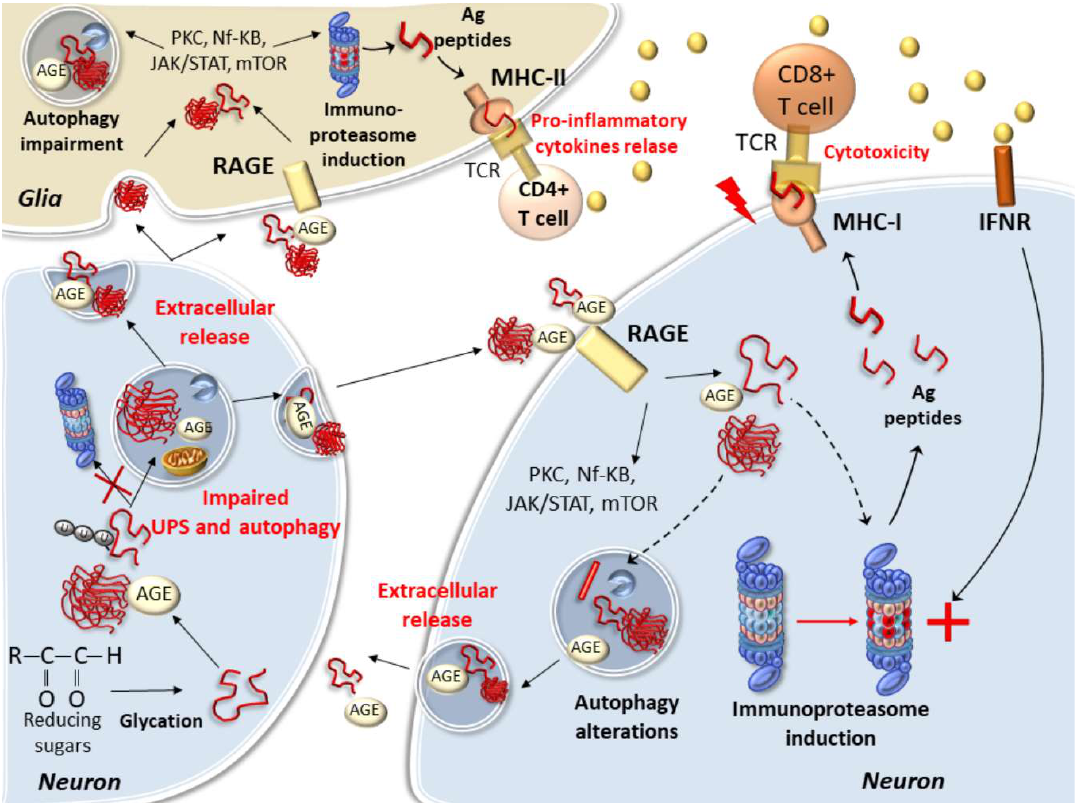
Figure 2. Autophagy and UPS alterations bridging altered proteostasis with neuroinflammation, the paradigm of protein glycation. Within neurons, glycation leads to the formation of advanced glycation end products (AGEs) which structurally modify proteins while promoting the formation of oligomer species. These in turn may impair the UPS while engulfing the autophagy pathway. Thus, indigested AGE-modified proteins may be released extracellularly upon merging of autophagy compartments with the plasma membrane. In neighboring cells, including neurons and glia, the presence of RAGEs allows binding and entering of prionoids. While spreading prionoids in neighboring cells, the binding of AGEs with RAGEs triggers a variety of transduction mechanisms which bridge alterations in cell-clearing mechanisms with inflammatory events. In fact, the binding of AGEs with RAGEs triggers the activation of PKC, NF-kB, JAK2 / STAT1 and mTOR pathways, which promote a vicious cycle of inflammatory reactions while leading to the replacement of standard UPS subunits with immune-related ones, called immunoproteasomes. Besides fostering the replacement of standard- with immune-proteasome subunits, these pathways may also impair the autophagy machinery. This may contribute to further promote the extracellular release of indigested AGE-modified proteins. At the same time, the immunoproteasome triggers a variety of inflammatory and immune reactions by cleaving misfolded proteins specifically within immunogenic sites. This leads to the production of Ag peptides that are recognized by MHC-I and MHC-II in neurons and glia, respectively. The cognate Ag / MHC-I complex exposed on the neuronal plasma membrane induces proliferation of CD8 + T-cells while triggering CTL-mediated neuronal death. At the same time, Ag-peptides derived from the degradation of misfolded proteins which are phagocytosed by or routed via RAGEs within glial cells can be presented via MHC-II molecules for re-activation of CD4 + T cells. In this context, the immunoproteasome may cross-process Ags which bind on MHC-II molecules to prime CD4 + Th lymphocytes and fuel production of pro-inflammatory cytokines in the brain milieu. Cytokines, in turn, may further promote immunoproteasome induction within neurons through interferon receptors, leading to a vicious cycle of events bridging alterations in protein degradation with prion-like spreading and